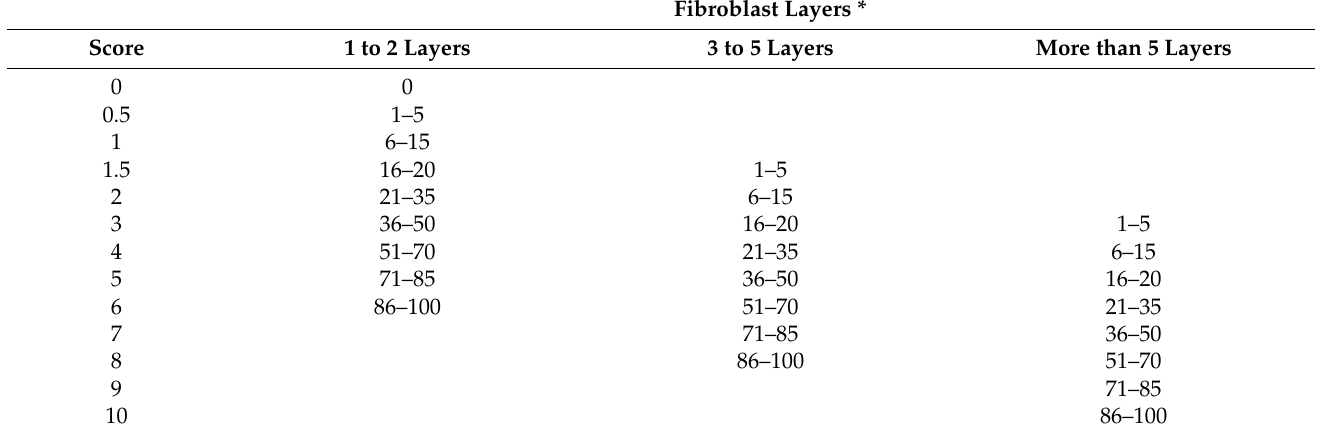
Table 1. Pancreas acinar fibrosis/atrophy score of the broilers vaccinated with the avian reovirus S1133 strain. Percentage (%) of Fibrous Tissue Bands Separating the Pancreatic Acini According to the Number of Fibroblast Layers